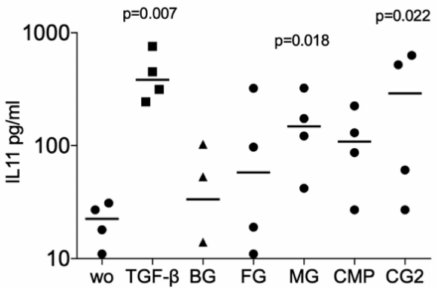
Figure 4. Supernatant and lysates of MG and CG2 increase interleukin 11 (IL11) signals in the